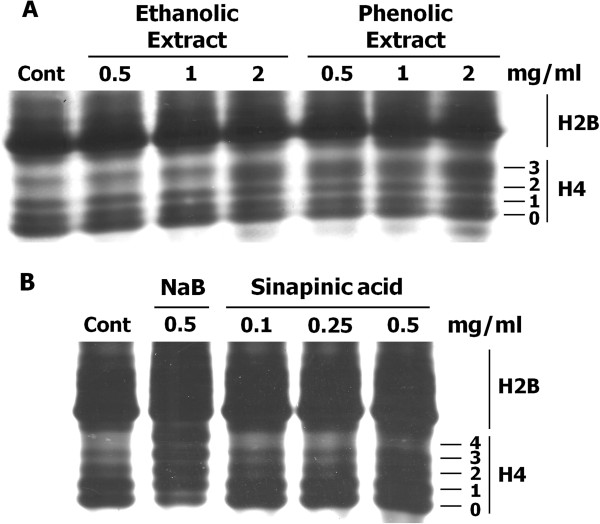
HDAC inhibitory activity of the plant extracts and sinapinic acid in HeLa cells. Effect of (A) ethanolic crude extract, phenolic-rich extract and (B) sinapinic acid on histone acetylation in HeLa cells. After 6 h-treatment, the level of histone acetylation was determined by AUT gel electrophoresis as described in Materials and Methods. Control (Cont) represents the level of histone acetylation in vehicle control treatment. The sodium butyrate (NaB)-treatment was used as a positive control. The degree of histone acetylation of histone H4 is indicated as follows: 0, nonacetylated; 1, monoacetylated; 2, diacetylated; 3, triacetylated; and 4, tetraacetylated. The data shown are representative of two independent experiments performed in duplicate.